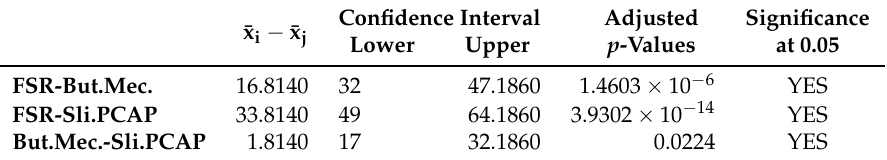
Table 4. Dunn & Sidak Post-Hoc Analysis for